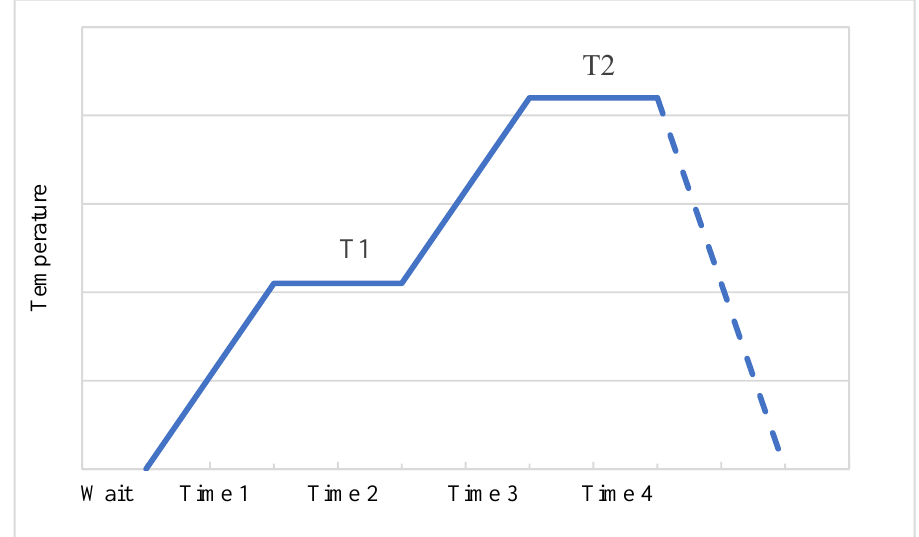
Figure 2. The pattern setting of the heating program.